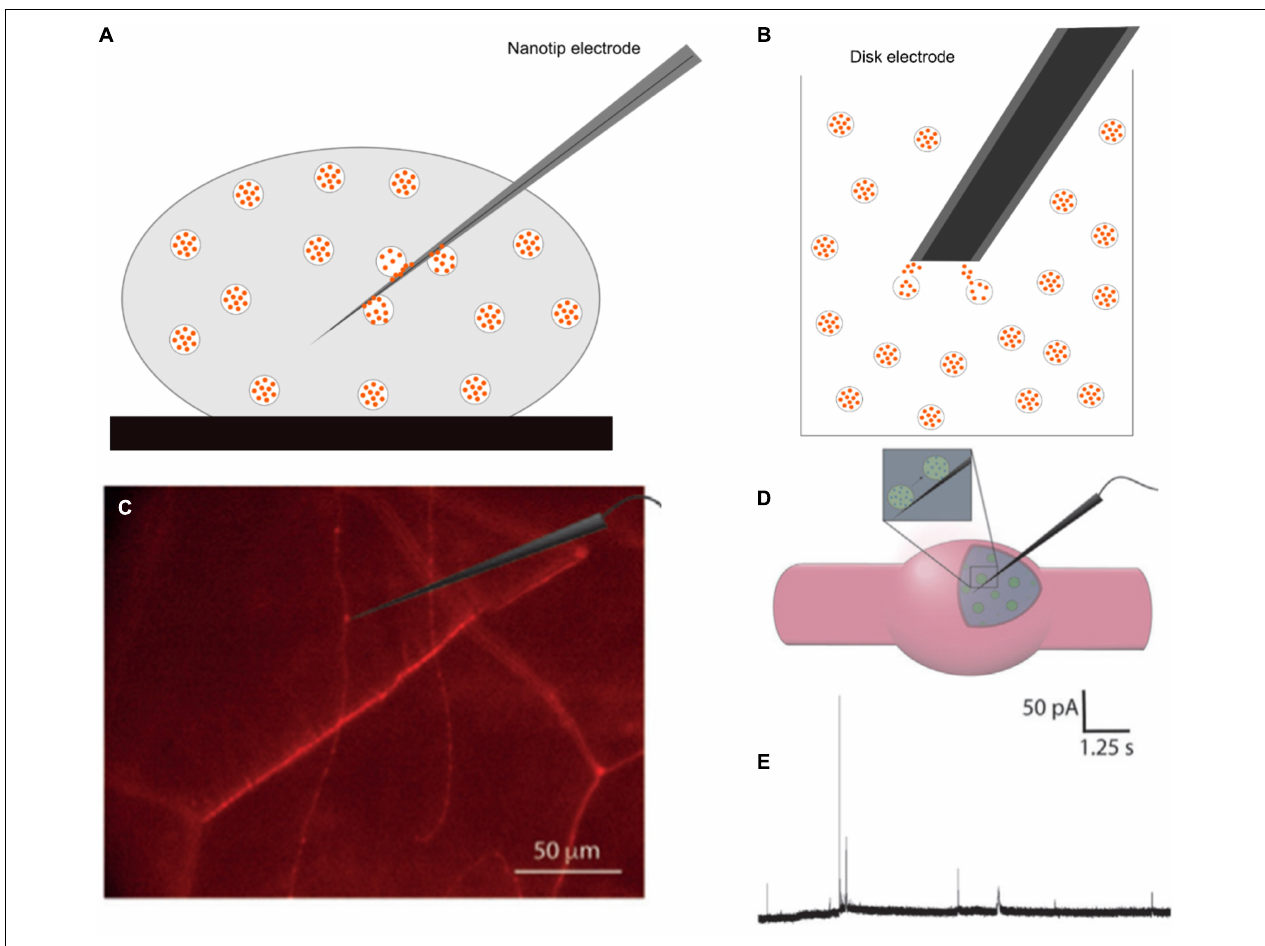
FIGURE 8 | Schematic of panel (A) intracellular vesicle impact electrochemical cytometry (IVIEC) with a nanotip electrode, (B) vesicle impact electrochemical cytometry with a 33- µ m disk electrode, (C) mCherry-labeled neurons in Drosophila larva under a fluorescence microscope and an electrode placed on or inside a varicosity, (D) position of a nanotip electrode in the varicosity, and (E) Representative current transients for IVIEC measurements. Panels (C–E) were reproduced from Larsson et al. (2020) under the creative commons license.